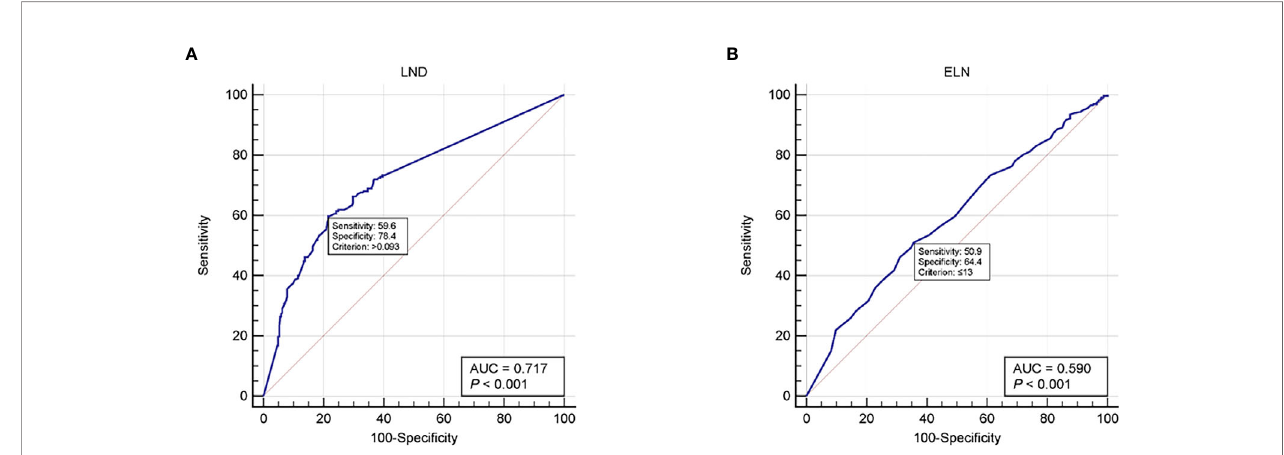
FIGURE 1 | ROC curves for (A) LND and (B) ELN. ROC, Receiver operating characteristic; LND, Lymph node density; ELN, Examined lymph